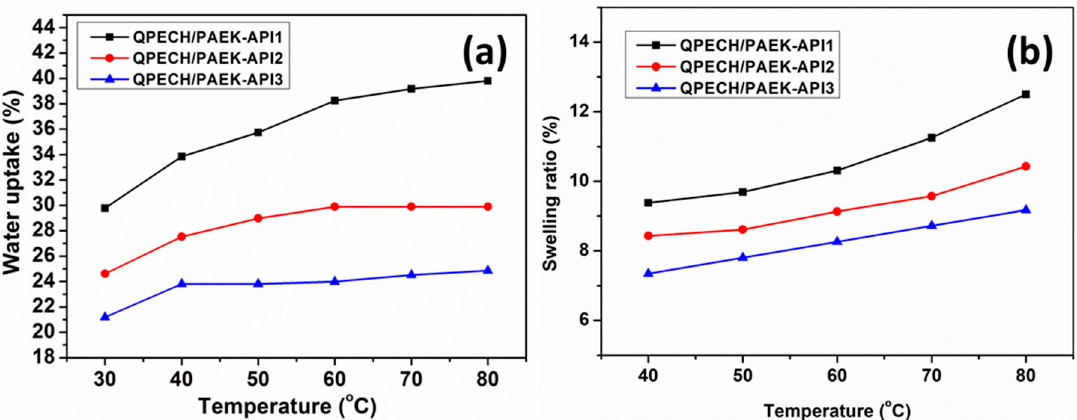
Figure 3. Temperature dependence of ( a ) water uptake and ( b ) length swelling percentage for QPECH / PAEK-API membranes.